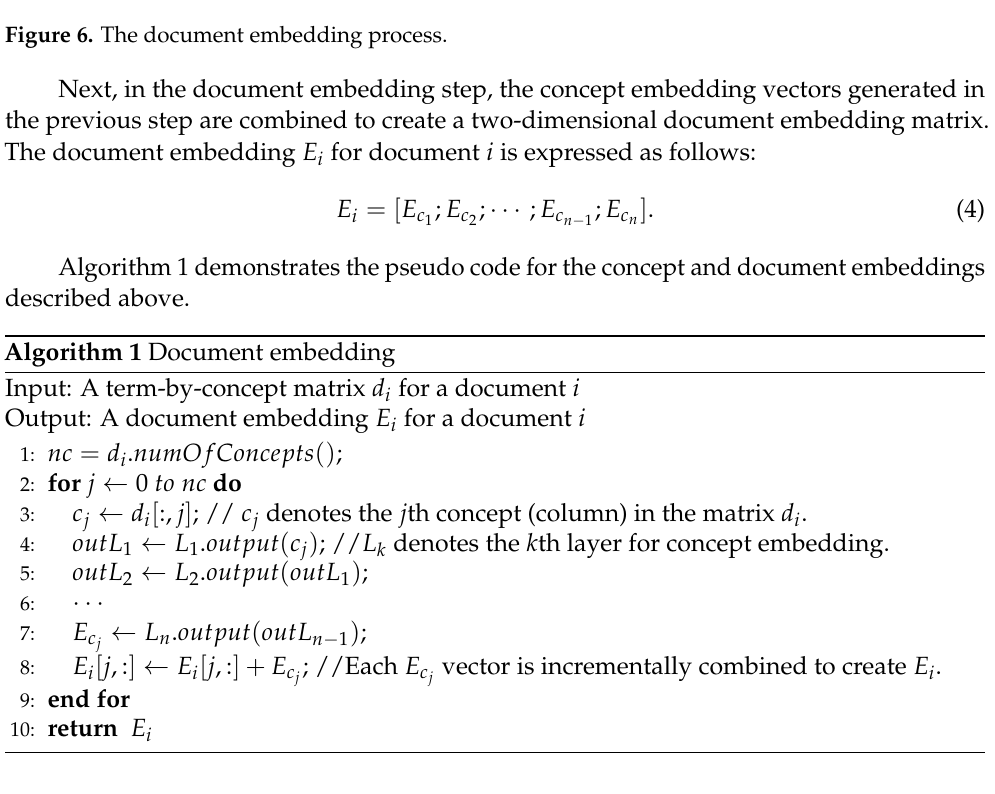
Figure 6. The document embedding